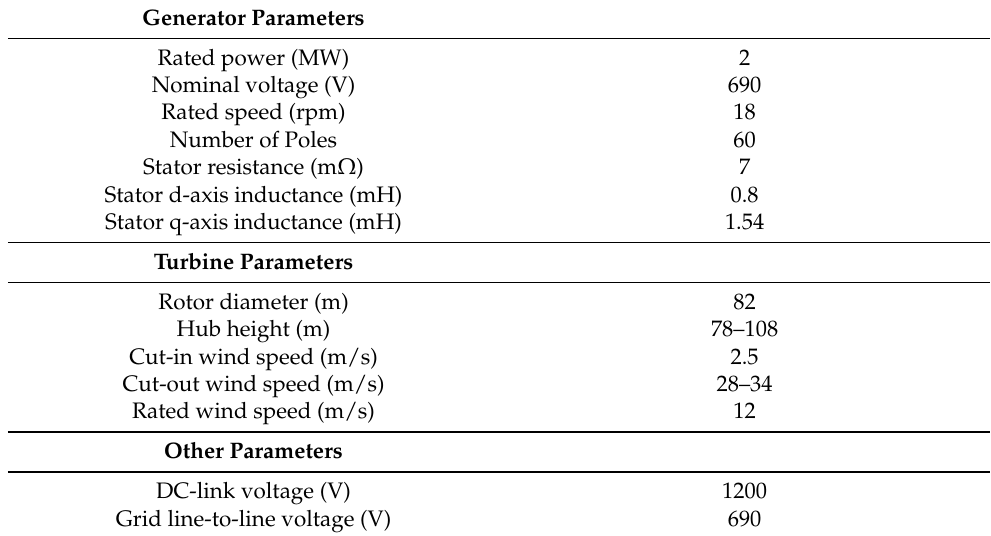
Table 2. Generator and other